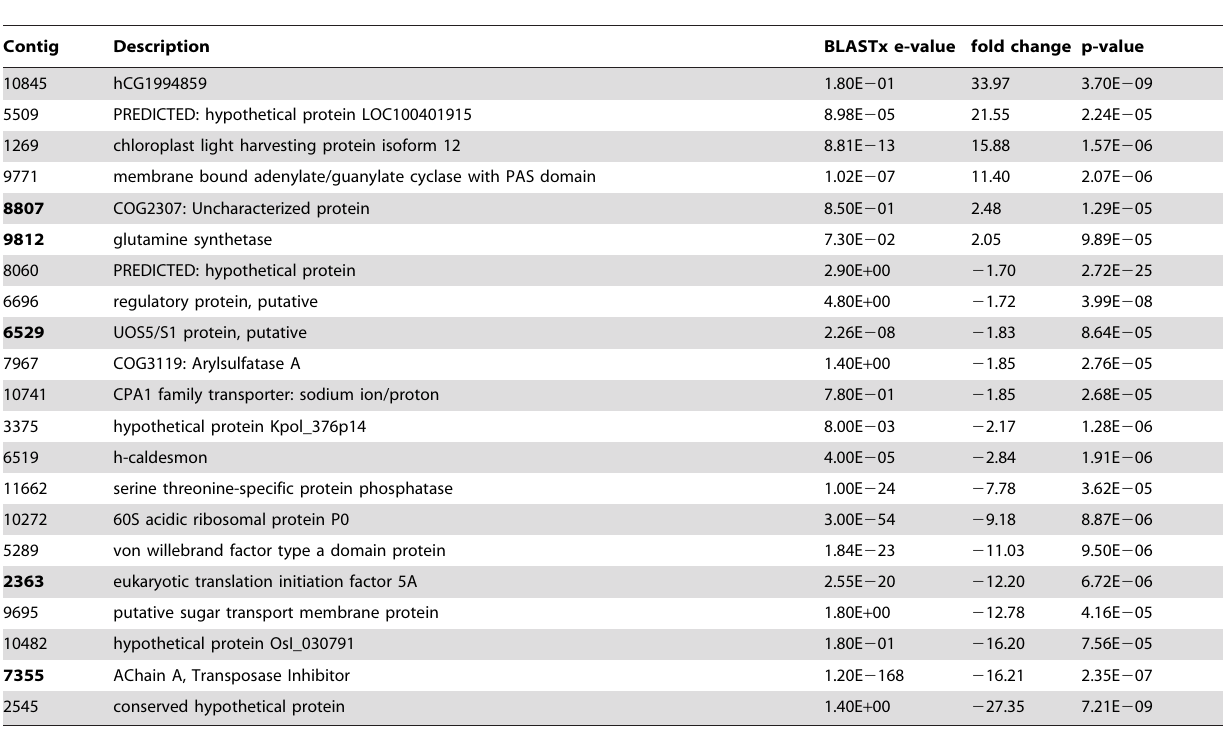
Table 2. Array features with significantly different abundance during the first hour post-nitrate addition, relative to N-depleted